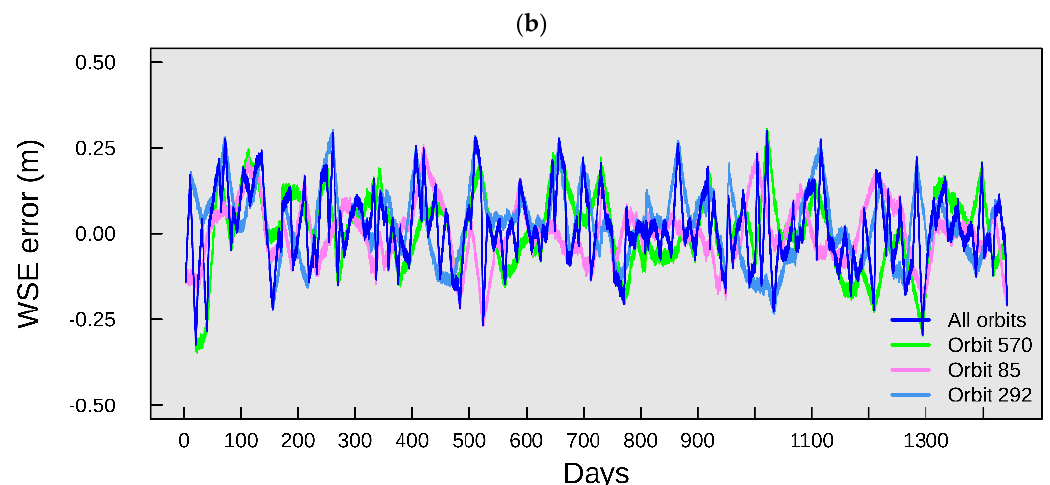
Figure 7. Daily evolution of the water surface elevation ( a ) and anomalies ( b ), both in meters, calculated for the T6G2 gravel pit on a four-year period (2015–2019), considering each orbit separately and together.